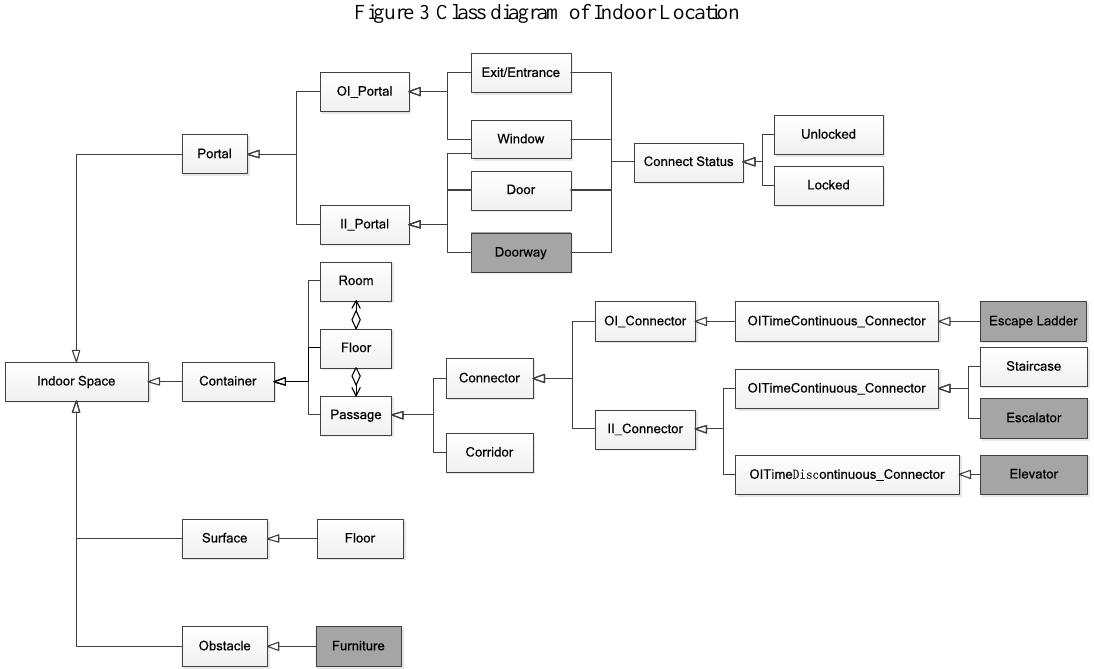
Figure 3 Class diagram of Indoor Location